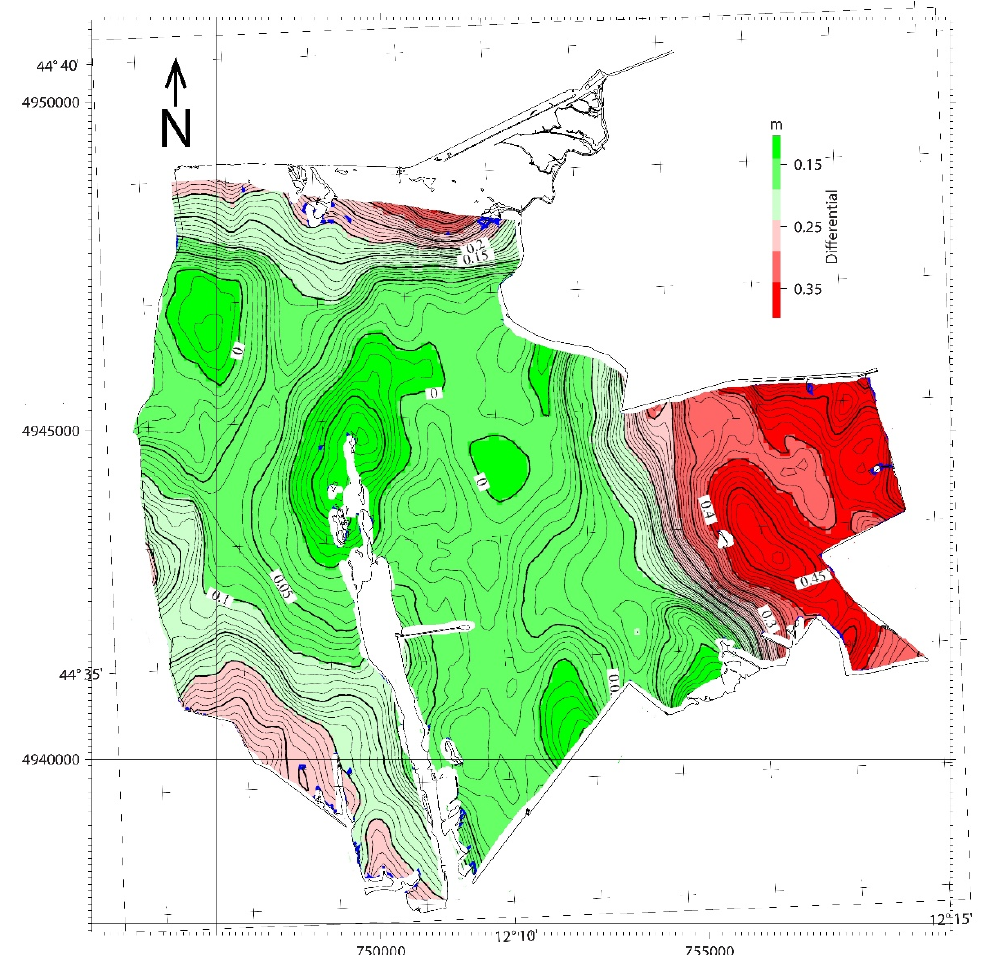
Figure 13. Residual bathymetric map obtained subtracting data collected at about 20 years of time- interval (old-new). Green color indicates stable (or regionally subsiding) areas while negative values (towards red) faster differentially subsiding sectors (Projection UTM 32 N). Note maximum differential subsidence in the eastern sector.